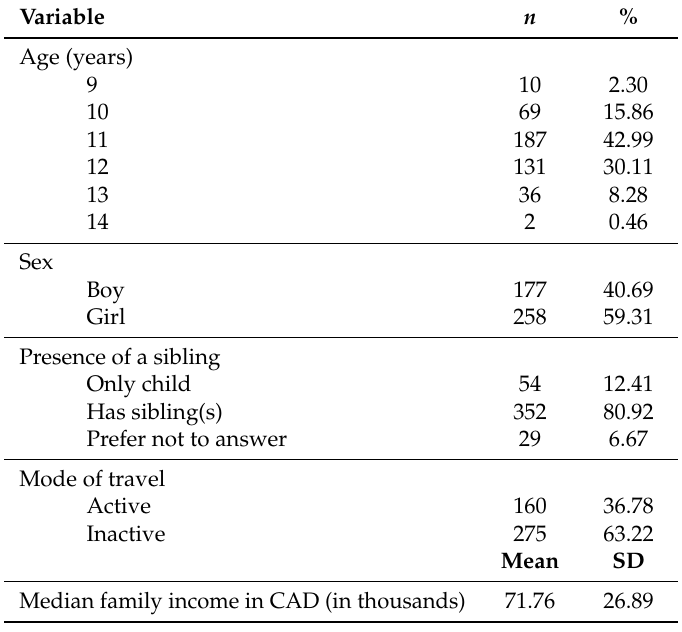
Table 2. Descriptive statistics for average daily minutes of MVPA ( n = 435).